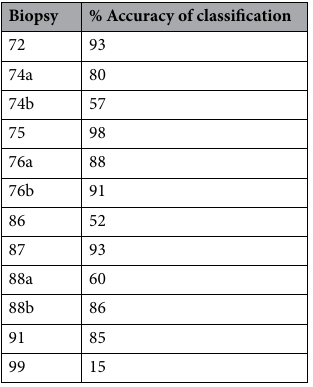
Table 4. Accuracy of classification of the spectra acquired each individual, measured as a percentage of spectra classified correctly as Ki67 low or Ki67 high.